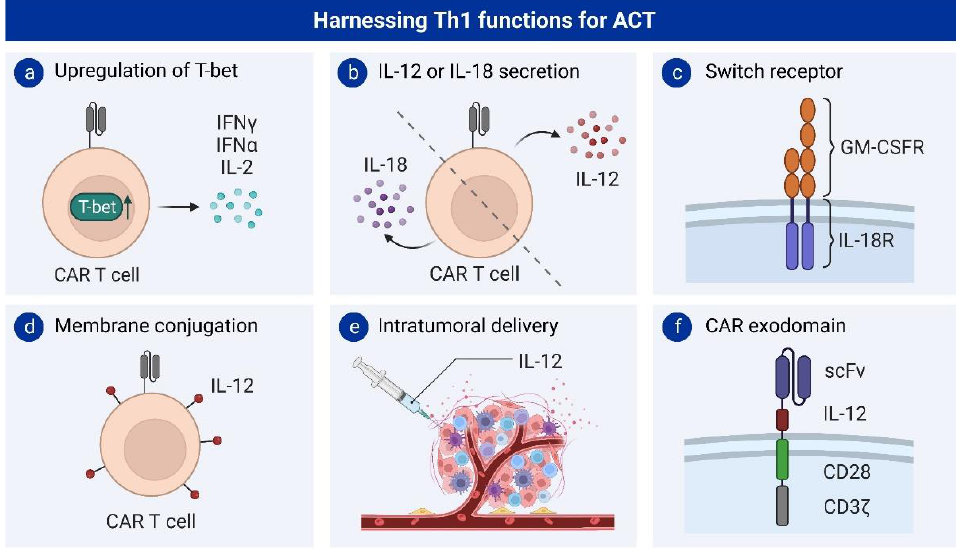
Figure 2. Strategies harnessing Th1 functions in ACT: ( a ) Upregulation of the Th1 transcription factor T-bet. ( b ) CAR T cells secreting IL-18 or IL12. ( c ) Chimeric GM-CSFR/IL-18R receptor. ( d ) Conjugation of IL-12 on the membrane of CAR T cells. ( e ) Intratumoral delivery of IL-12. ( f ) Integration of IL-12 in the CAR exodomain. scFv: single-chain variable fragment.